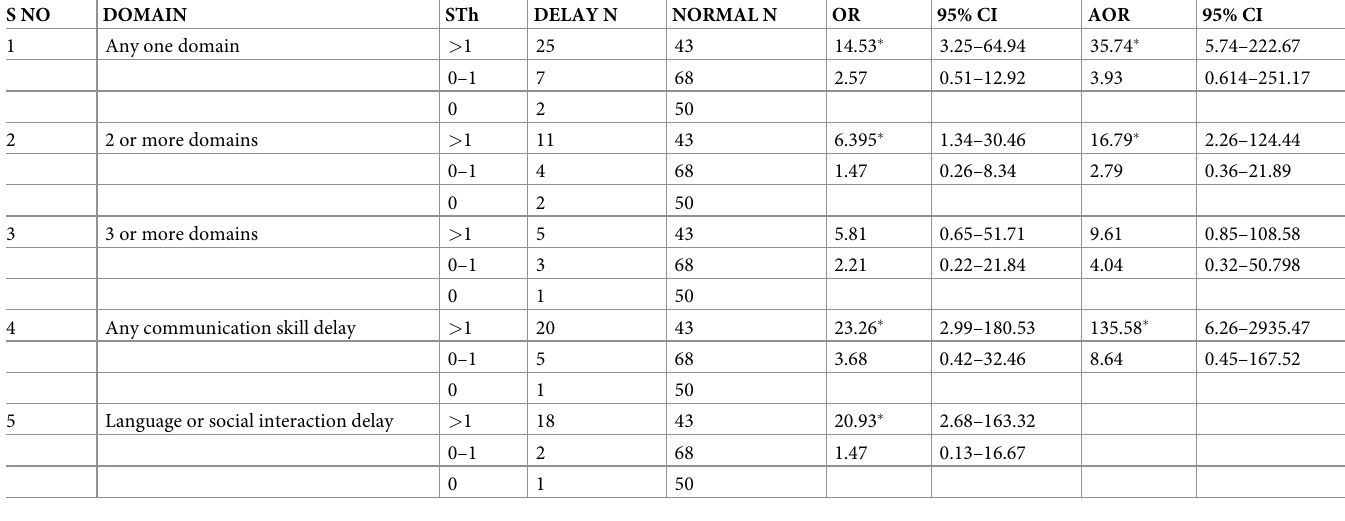
Table 6. Association between screen time in hours (STh) and child development among children aged 6–23